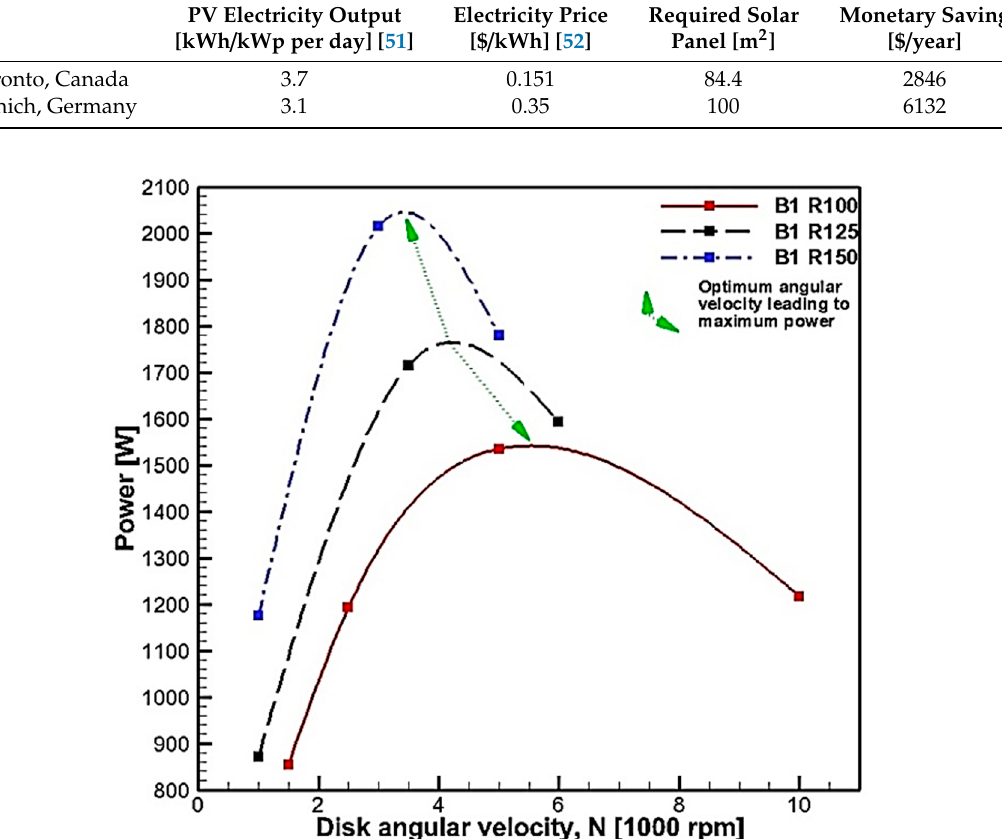
Figure 5. Variation of TT output power with the angular velocity with a fixed gap size.